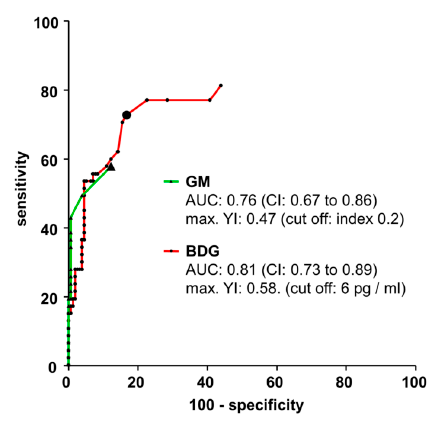
Figure 2. Receiver operating characteristic (ROC) curves. Measurement results of the samples of the control group and the single serum sampled closest to the day of proven diagnosis each IA patient were used to calculate ROC curves for the GM ELISA (triangles) and the BDG assay (circles). Data points with the maximum Youden’s index (YI) for the individual curves are labelled by large symbols. AUC area under the curve; CI confidence interval.